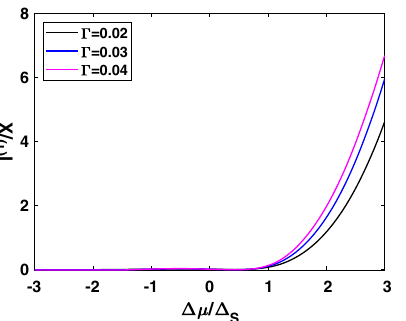
Fig. 5 Quasiparticle-tunneling current with broadened spectral functions. X ¼ 2 mk ð Ω 2 þ Ω 2 Þ = π 3 is the normalization constant for the current, " ; 3 # ; 3 F where k F is the Fermi momentum and Ω σ ,3 represent the Rabi couplings. The black, blue and purple solid lines depict the quasiparticle-tunneling currents with the widths of spectra Γ / E F = 0.02, 0.03, and 0.04, respectively. The values of the chemical potential μ S and gap energy Δ S are set to be μ S / E F = 0.38 and Δ S / E F = 0.47 as those in unitary limit, while T is set as T / T F = 0.06 ( E F and T F are the Fermi energy and Fermi temperature of the super fl uid reservoir,